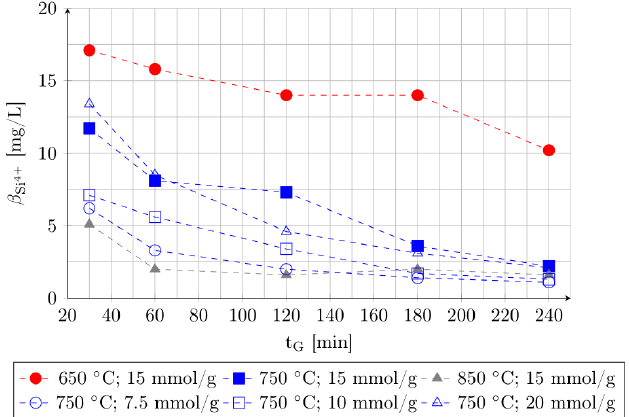
Figure 8. Effect of acidity of leaching medium on separation of Zr 4+ (+Hf 4+ ), Al 3+ and Fe 3+ ( (cid:1866) H + /(cid:1865) conc. = 15 mmol/g; T G = 750 °C; t G = 2 h; ϱ PD,L = 25 kg/m 3 ; T L = 20 °C; t L = 24 h; r R,L = 300 rpm).